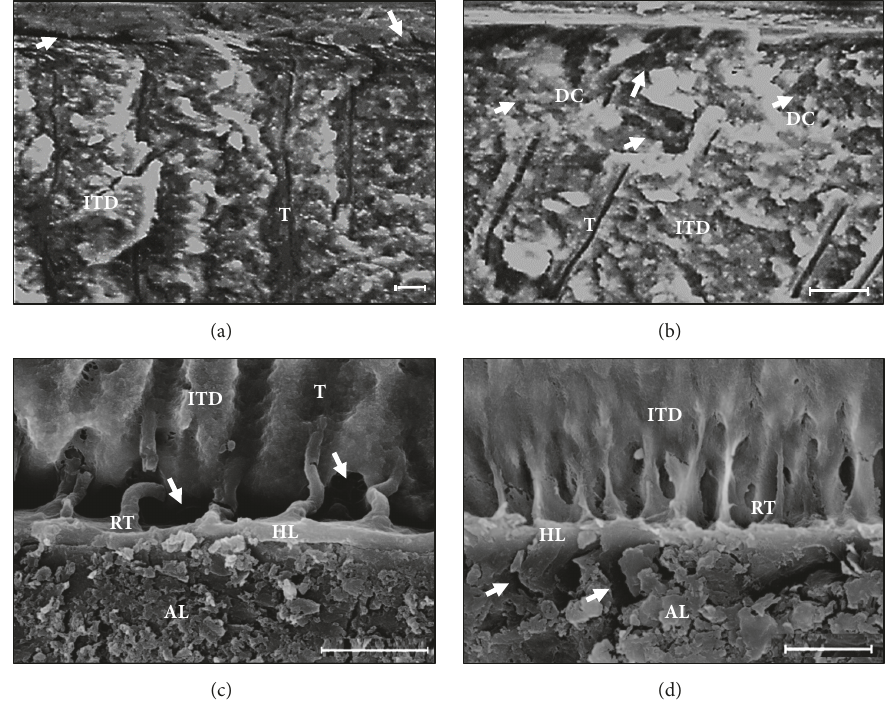
Figure 4: Resin-dentin inter f ace w it h 150 days o f aging by SE M . (a) Arrows show voids in the deepest portion of hybrid layer. (b) Degradation of collagen fibrils is evidenced (arrows) in the adhesive interface. (c) Loss of collagen in the intertubular dentin around the resin tags (arrows). (d) Degradation of the bonding interface with formation of water channels (arrows) and hydrolytic degradation of the resin adhesive. Bonded interfaces were created with Adper Single Bond 2 (3M ESPE, St. Paul, MN, USA). (SEM) scanning electron microscopy, (ITD) intertubular dentin, (T) dentin tubule, (DC) degraded collagen, (RT) resin tags, (HL) hybrid layer, (AL) adhesive layer. Bar corresponding to 10 𝜇 m. Courtesy of Betancourt DE and Baldion PA with